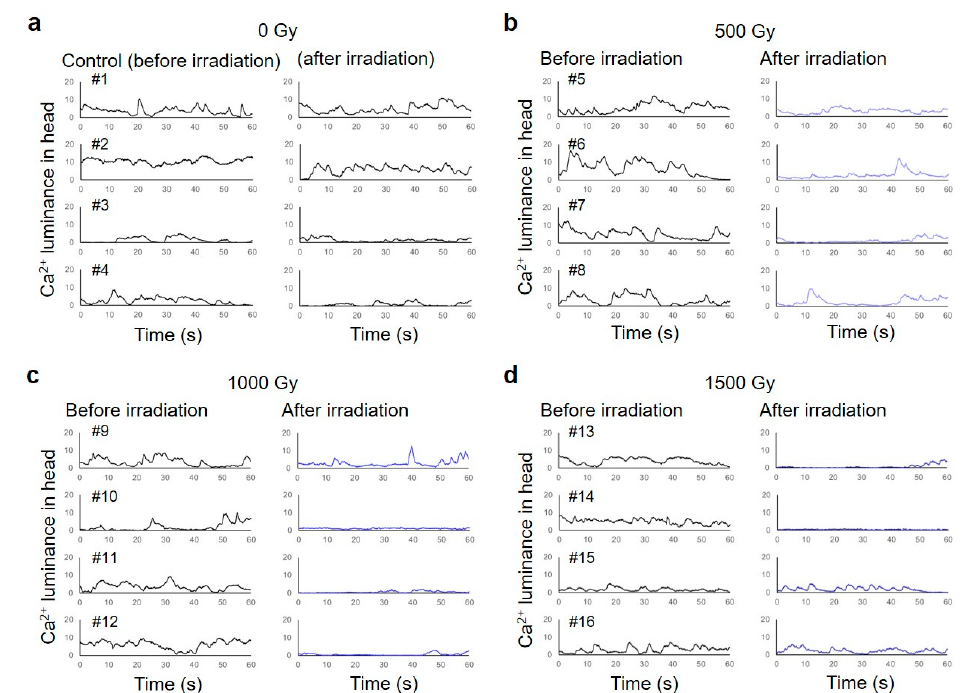
Figure 1. Schematic of the CNS-targeted irradiation of individual live C. elegans using a microfluidic chip. ( a ) Cross-sectional view of CNS-targeted irradiation of a live C. elegans enclosed in a microfluidic channel of a microfluidic chip. Anatomical structure of an individual C. elegans in the right panel was compiled with reference to a previous report [3]. ( b ) Schematic of a 300-µm, ultra-thin, ion-penetrable, wettable, microfluidic chip (Worm Sheet IR) enclosing live C. elegans individuals in the microfluidic channels. ( c ) Overhead view of the anterior body of an individual live C. elegans enclosed in a straight microfluidic channel of a microfluidic chip. The whole nerve ring in a ⌀ 60-µm micro-aperture region (filled in blue) or the center of the nerve ring (CNS) in a ⌀ 20-µm micro-aperture region (filled in yellow) were targeted and irradiated with an exact number of carbon ions.